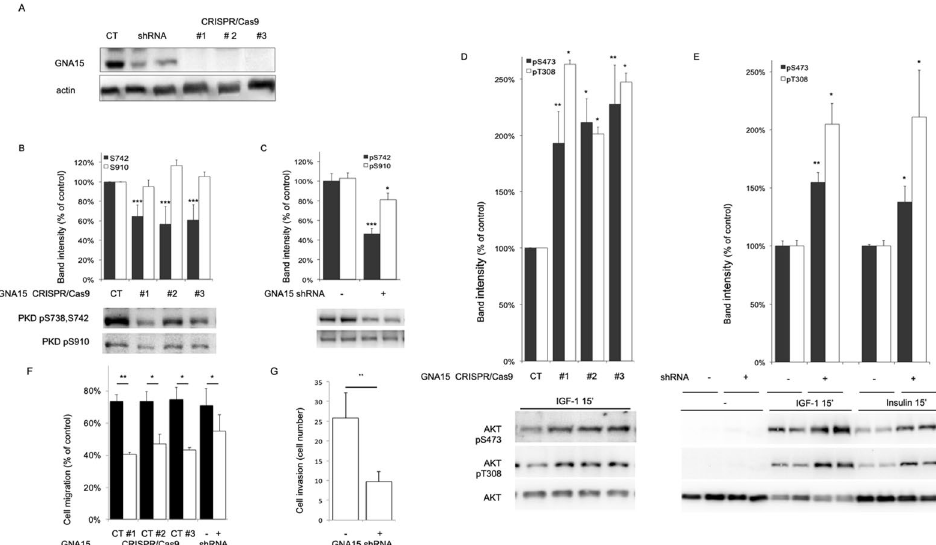
Figure 5. Functional consequences of Gα15 signaling. ( A ) In PT45 cells Gα15 was down-modulated by IPTG inducible shRNA expression or knocked out by CRISPR/Cas9 in all alleles of 3 independent clones, as confirmed by DNA sequencing. Protein down-modulation was confirmed by immunoblot as shown and quantified as 70% ± 9% of control (n = 4). ( B ) The impact of preventing Gα15 expression was evaluated by immunoblot analysis of phospho-amino acids diagnostic of the activation state of PKD1 (n = 10). ( C ) The impact of down- modulating Gα15 expression was evaluated as in B (n = 10). ( D ) The impact of preventing Gα15 expression in 100 nM insulin was evaluated as in D (n = 8). ( F ) PT45 cell motility assessed in scratch assays. Representative images are shown in Supp. Fig. S12. ( G ) PT45 cell invasion of collagen-coated membranes. Data are